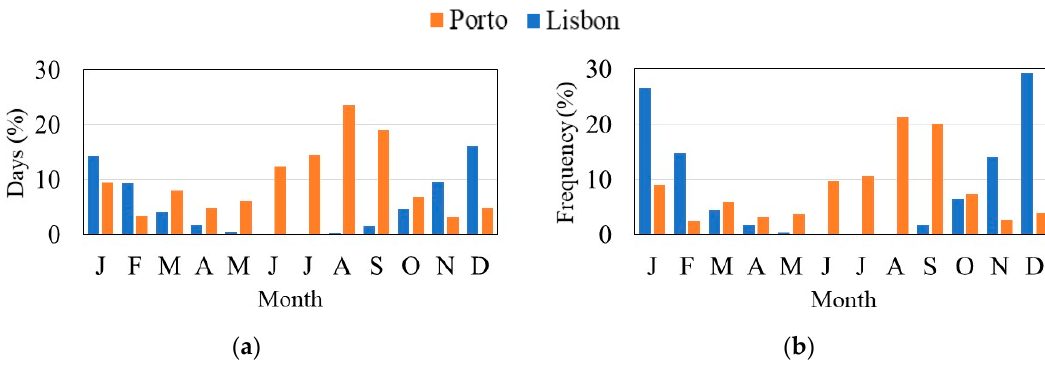
Figure 4. Monthly distribution of the fog at Porto and Lisbon airports in the period between 2002 and 2011: ( a ) daily fog occurrences and ( b ) whole period fog occurrences.